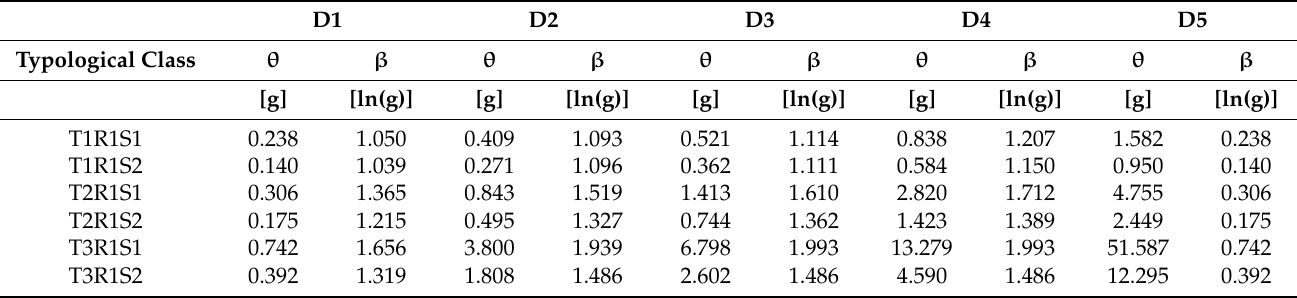
Table 6. Parameters of log-normal fragility curves for the census-based typological classes accounting for construction timespan, State of repair R1, and number of